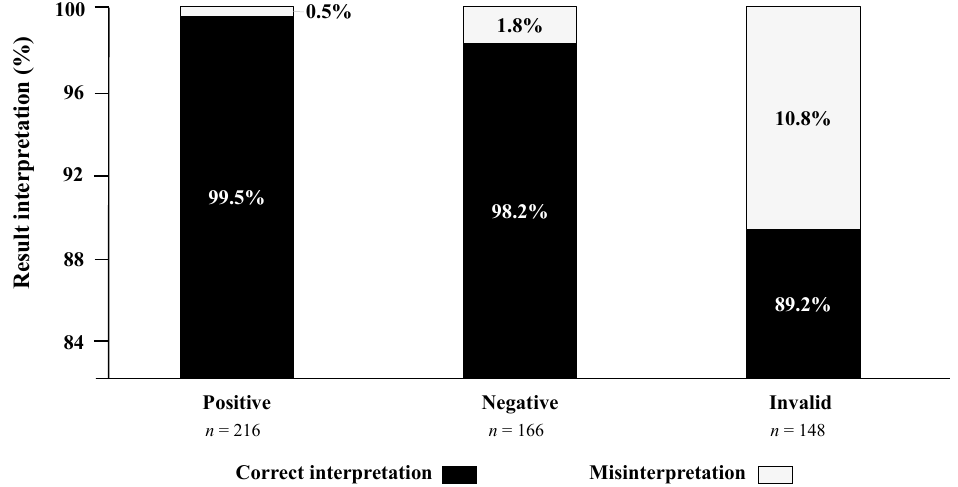
Figure 3. Stacked columns showing the ability of participants to read and interpret (correctly or incorrectly) the 530 results of the BIOSYNEX Antigen Self-Test COVID-19 Ag+ (Biosynex Swiss SA) obtained from successive random selection of a panel of 7 standardized tests, including three positive, two negative, and two invalid test results.